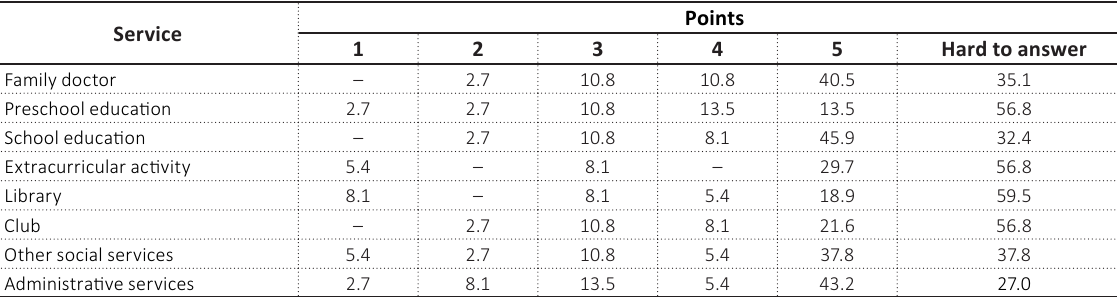
Table 3. Quality of social services provided by Pidberiztsivska community: Subjective estimates of IDPs, % of respondents